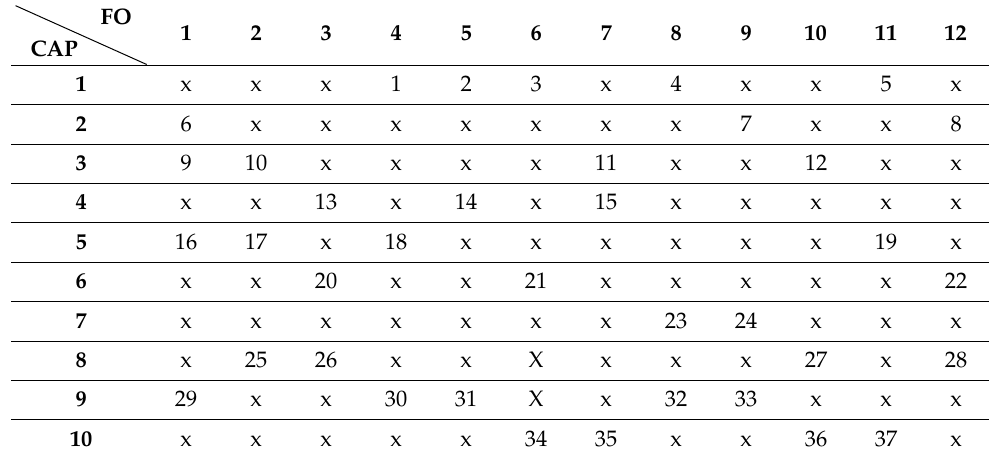
Table 4. Set of admissible